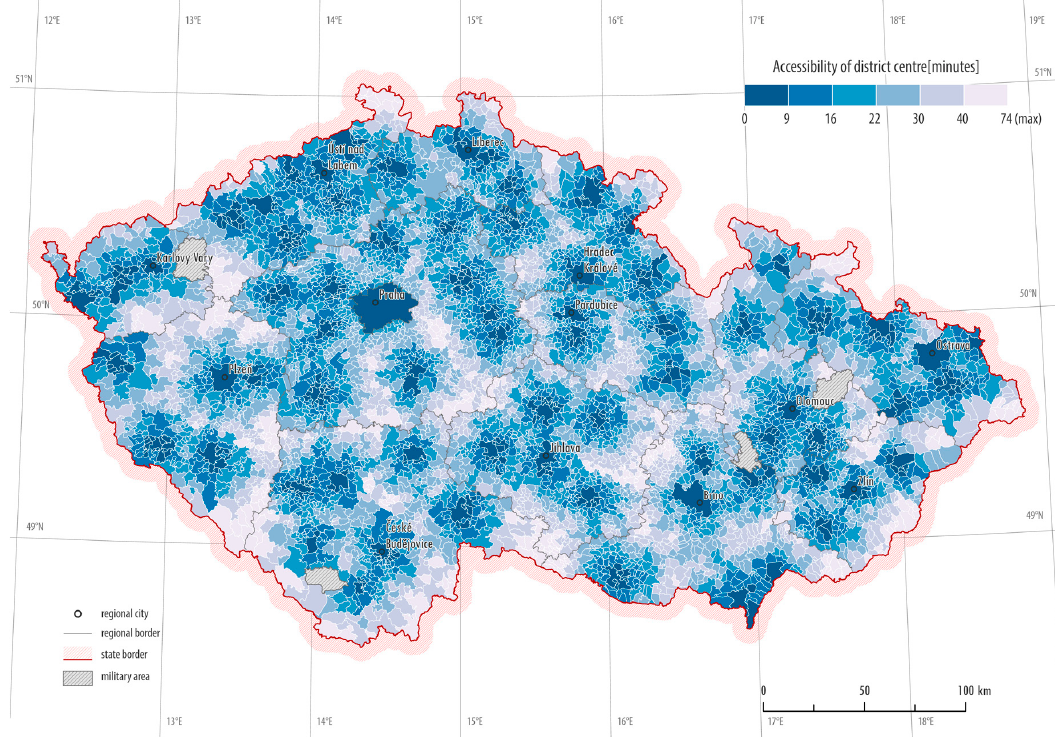
Figure A1. Accessibility of district